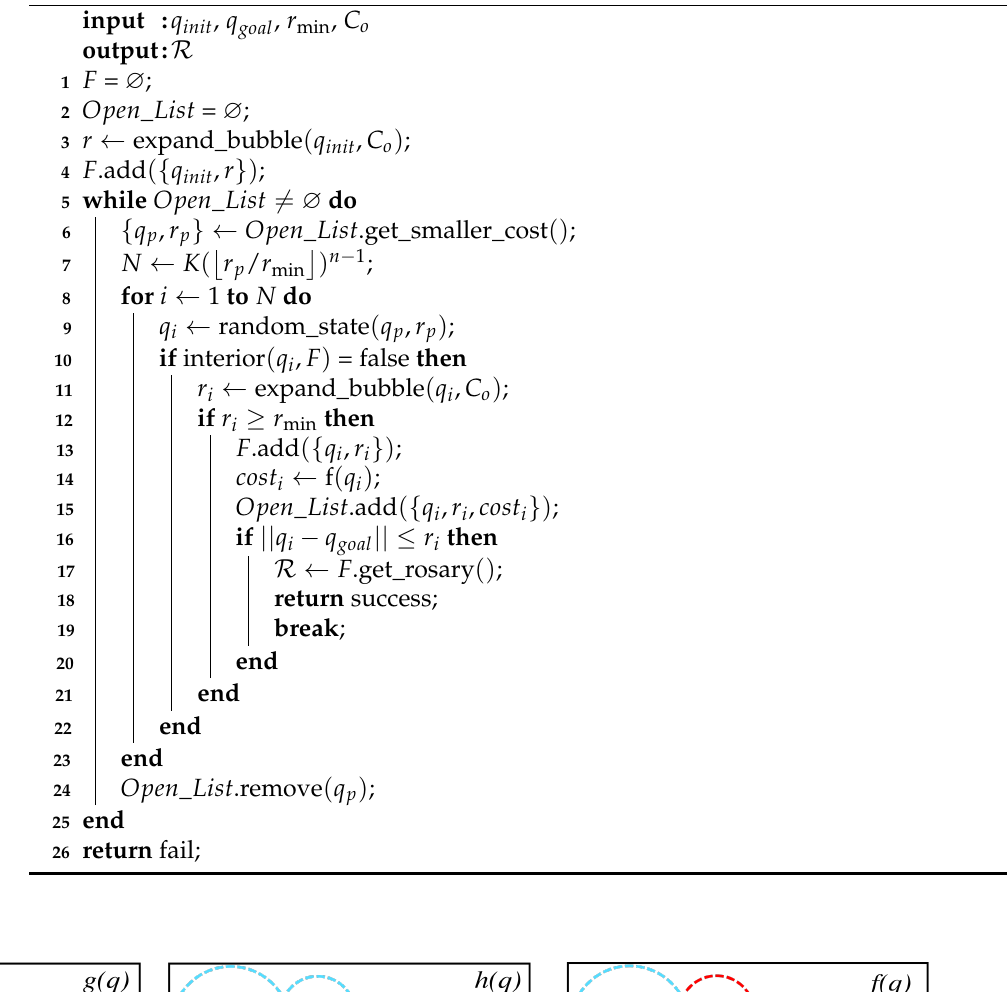
Algorithm 4: Heuristic-Guided Probabilistic Foam.